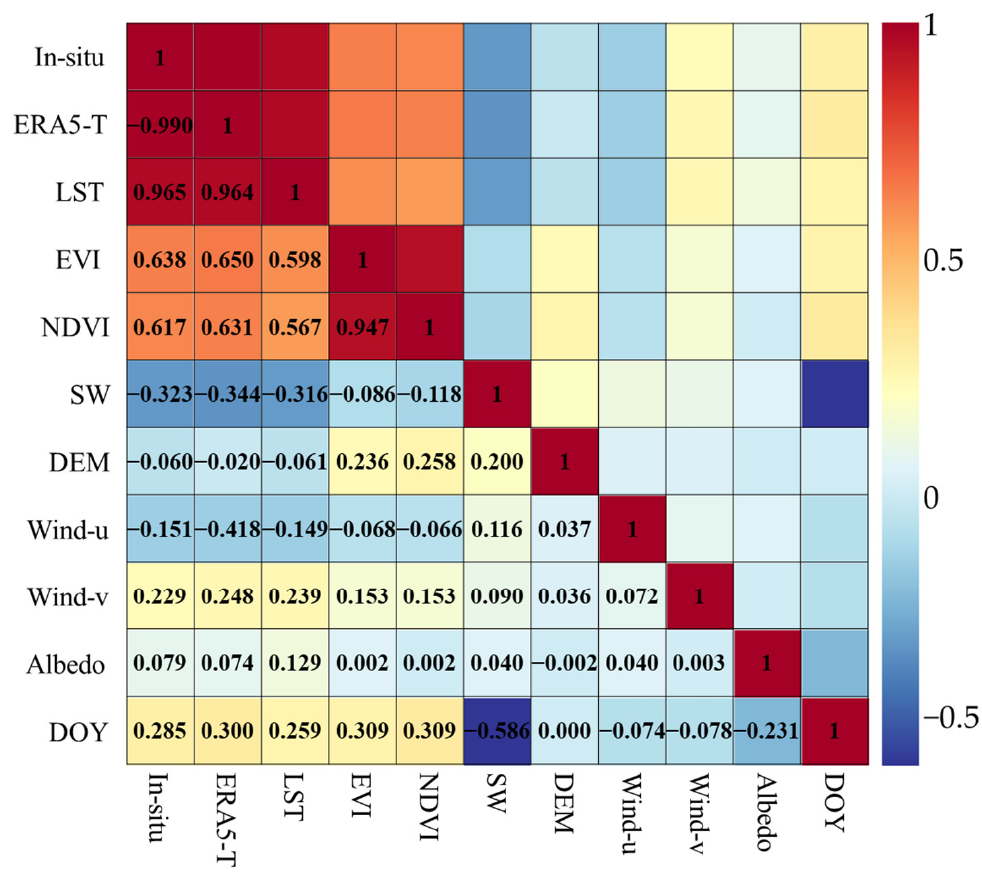
Figure 4. Pearson correlation coefficients among the input variables and in situ temperature.